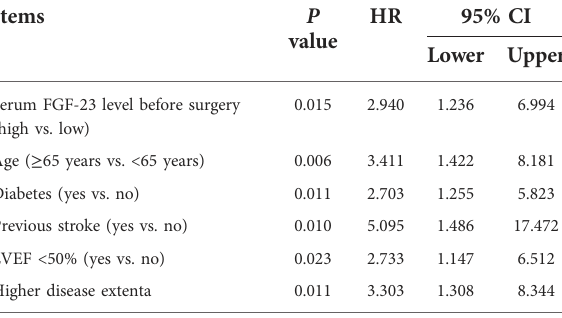
HR 95% CI value Lower Upper